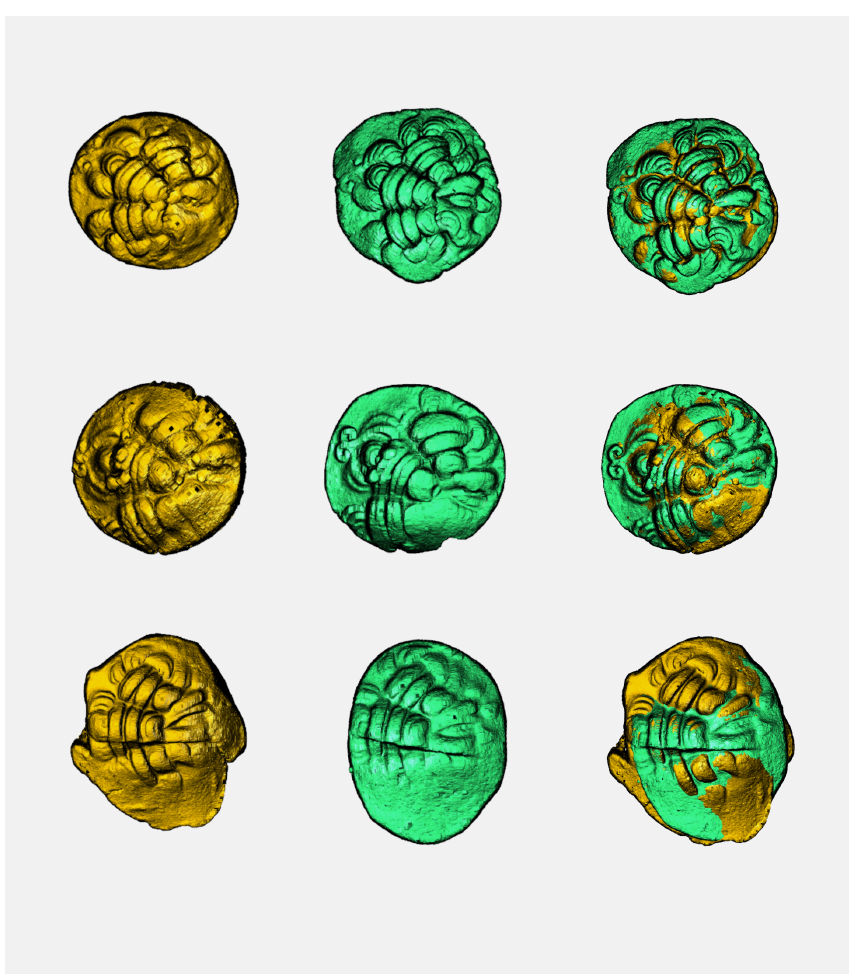
Figure 7. Qualitative results of global registration of pair of coins using Random Search ICP.